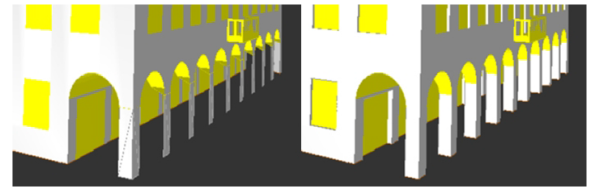
Figure 8. LoD3 Model with arches (left: after simplification) (SIG-3D Quality Working Group, 2012)